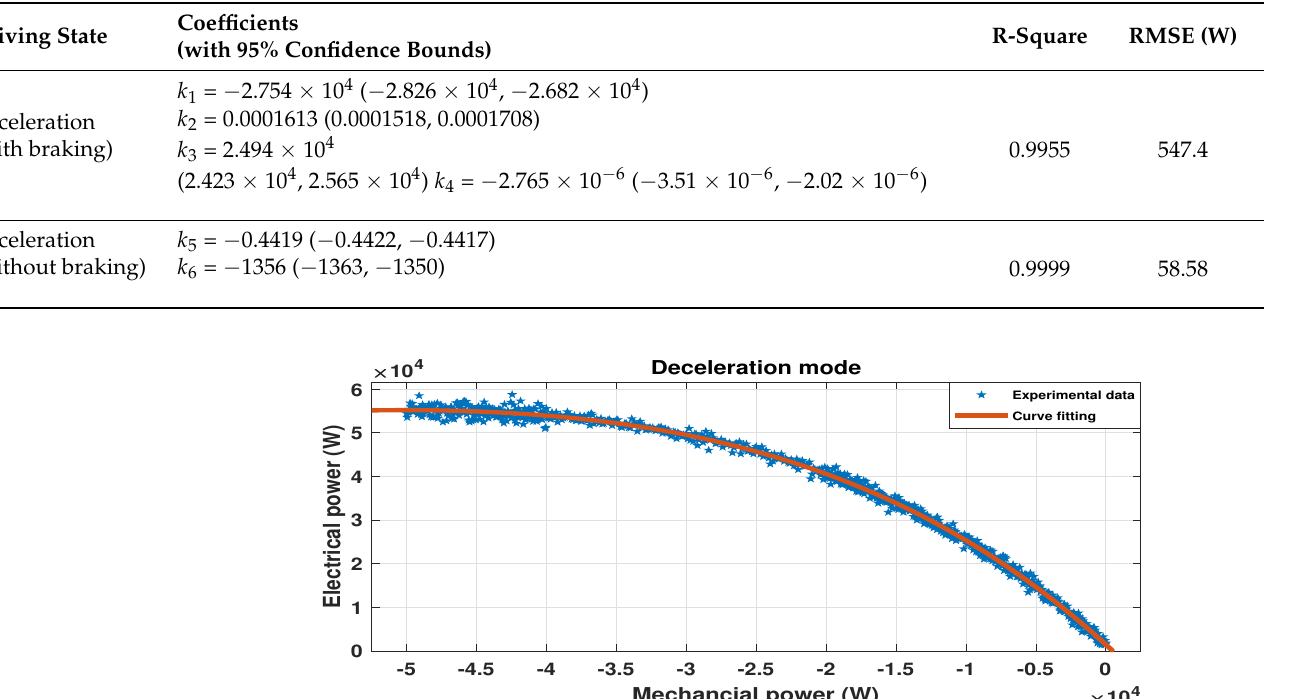
Table 7. Coefficients and performance of elaborated models.